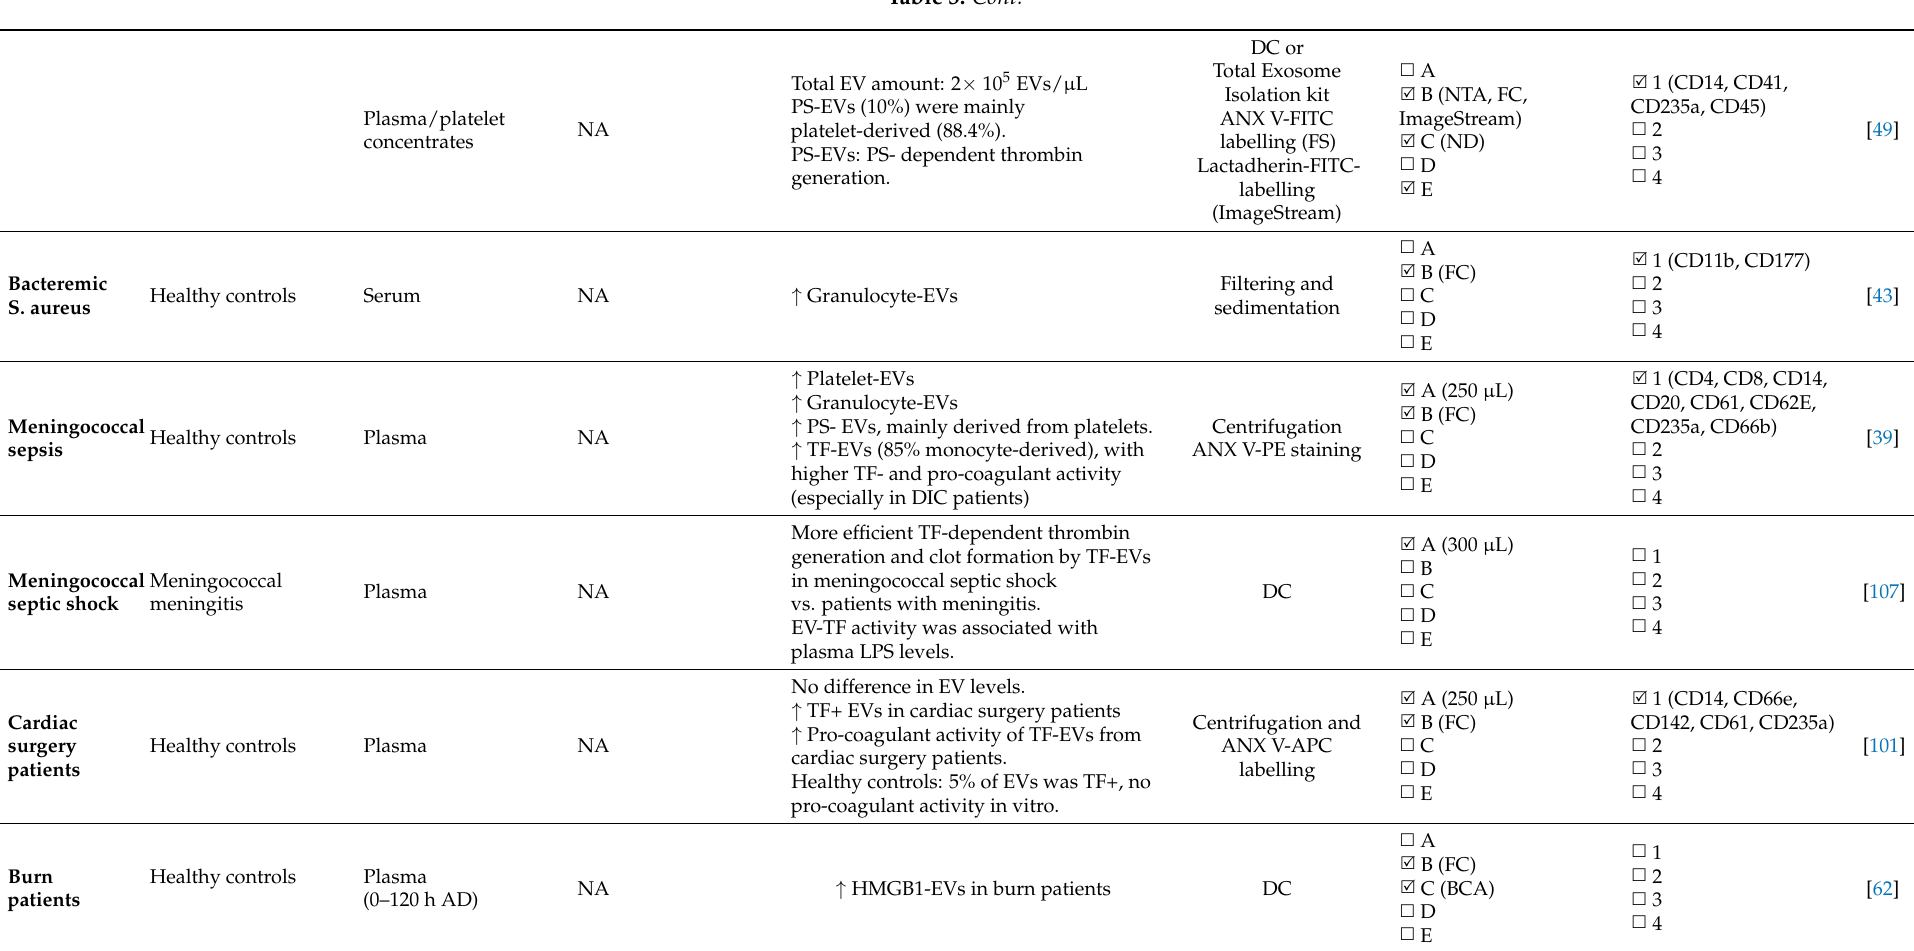
Organ damage propagation via oxidative stress and in- flammation: Heart: ↑ COX1, COX2, SOD, eNOS. Lungs: COX-2, NF κ B levels affected. Liver: ↓ eNOS, manganese SOD.